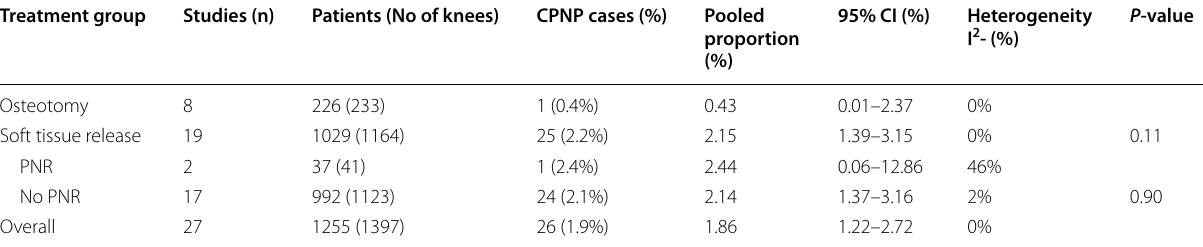
No Number of, CPNP Common peroneal nerve palsy, PNR Peroneal nerve release, CI Confidence interval